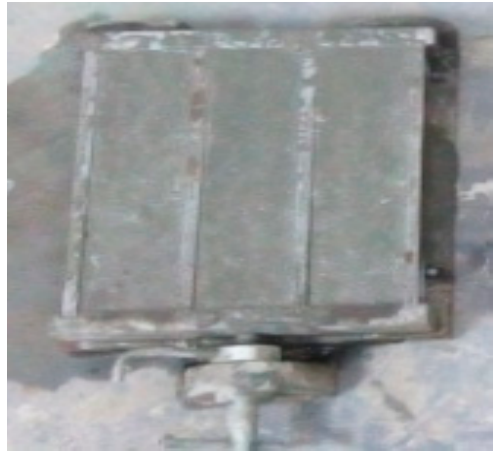
Table 2. Mix proportions of specimens.